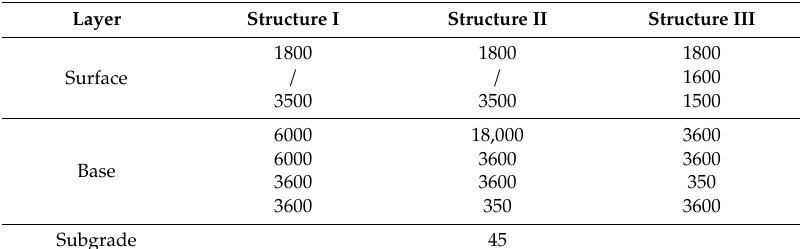
Table 2. Design parameters of pavement materials for each layer (unit: MPa).